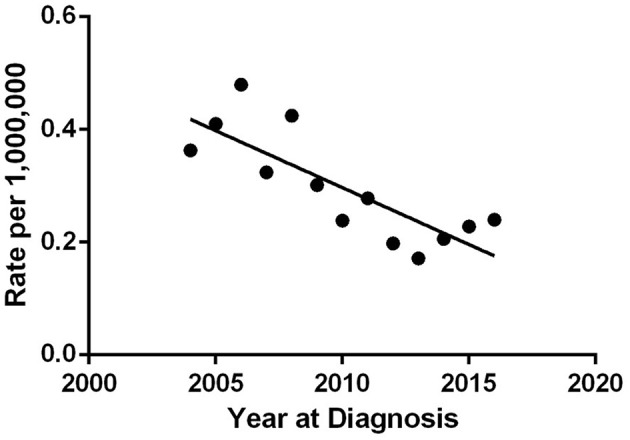
Age-adjusted incidence rate for mucinous PCa by year of diagnosis ranged from 0.36/1,000,000 in 2004 to 0.24/1,000,000 in 2016.